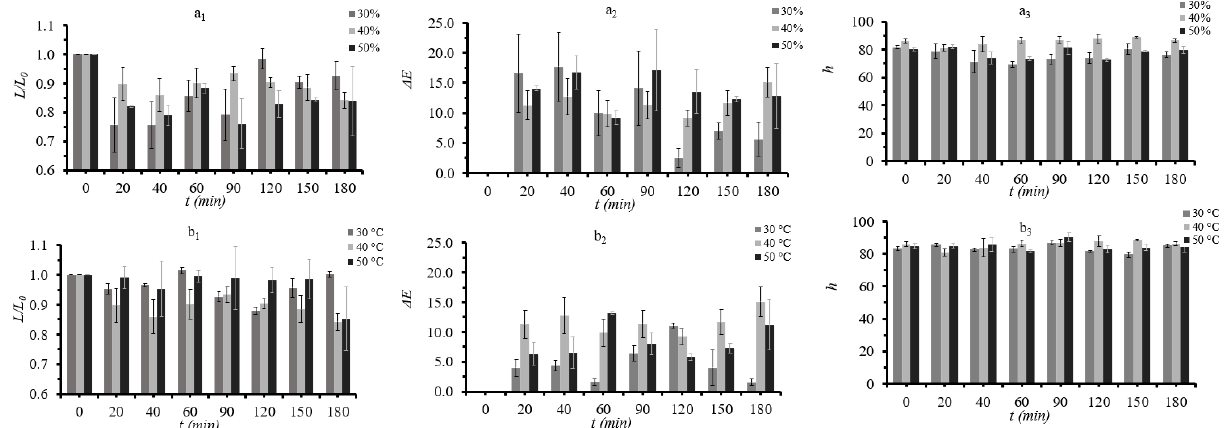
Figure 7. ( a 1 ): Relative lightness change (L/L 0 ), ( a 2 ): color difference ( ΔΕ ), and ( a 3 ): hue angle (h) during osmotic dehydration at 40 °C, at all three different glycerol concentration and ( b 1 ): lightness (L), ( b 2 ): color difference ( ΔΕ ), and ( b 3 ): hue angle (h) during osmotic dehydration at 40% glycerol concentration, at all three different temperatures. Points represent average values, and error bars represent the standard deviation from the three measurements.